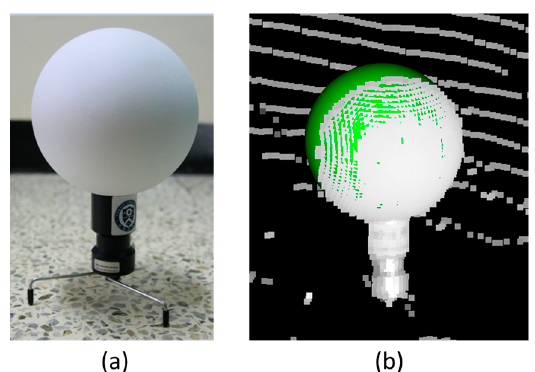
Figure 3. ( a ) Sphere target used for registration of terrestrial laser scanning data; ( b ) sphere target detected in a point cloud (the green sphere is a fitted sphere model).